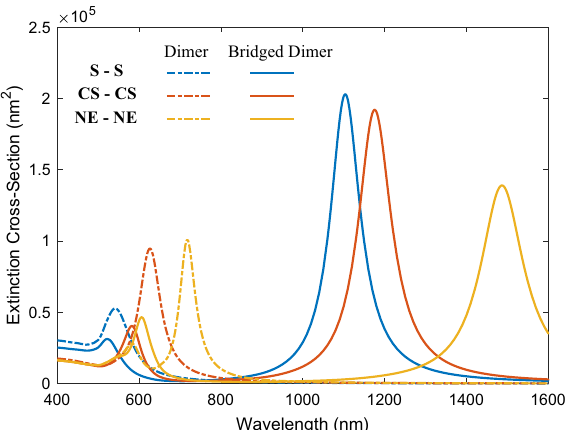
Figure 2. Extinction spectra of dimers and bridged dimers with different geometries. The dashed lines display the extinction cross-sections of bonding dimer plasmons of the dimers having 10 nm gap. The solid curves show the extinction cross-sections of screened bonding modes and charge transfer modes of conductively linked nanoparticles. The radius and length of the bridge are 10 nm. In all cases the radius of the shell is 40 nm. For nanostructures with cores and offset, the radius of the core is 30 nm and the core is replaced by 8 nm.